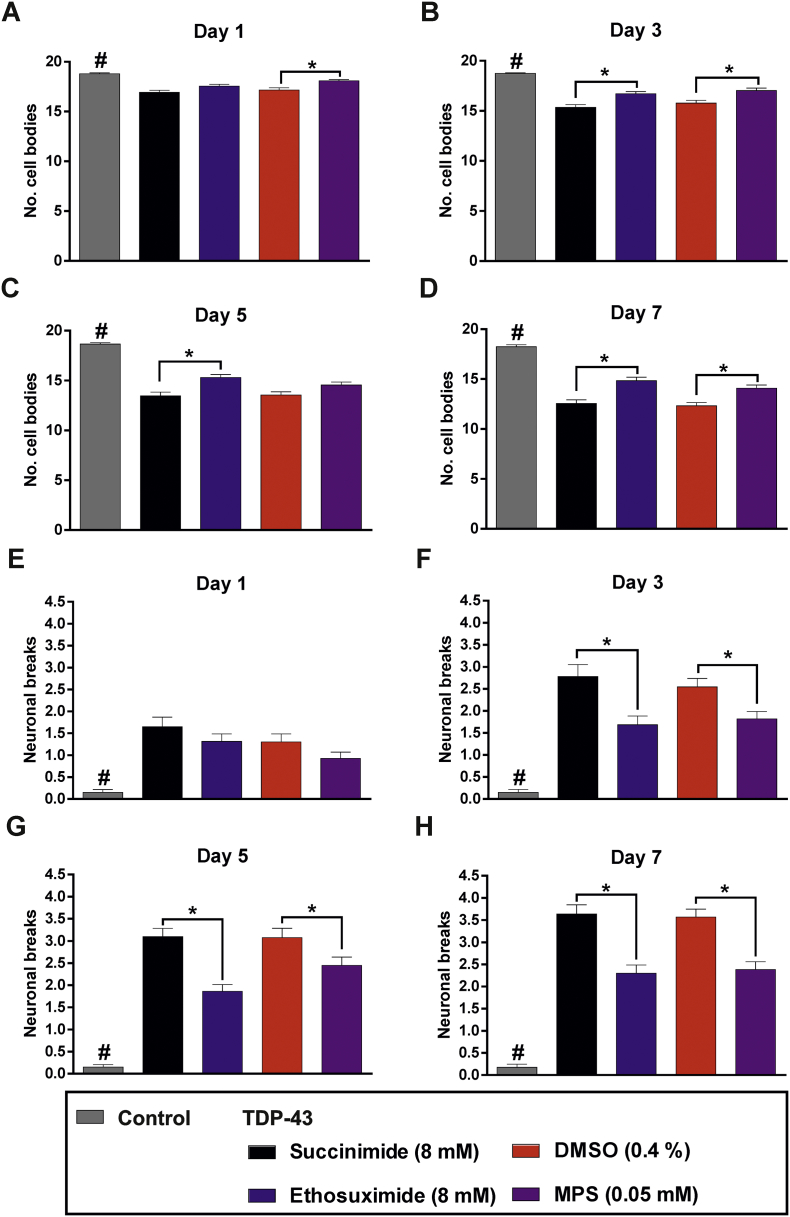
MPS ameliorates GABAergic neurodegeneration in the worm TDP-43 proteinopathy model. Age-synchronised wild type and TDP-43(A315T) worms expressing GFP under the control of the unc-25 promoter were chronically treated with the indicated compounds from the L1 larval stage onwards. (A-D) Wild type worms consistently preserved more of the 19 D-type motor neuronal cell bodies than TDP43(A315T) expressing worms at all assayed ages, verifying neurodegenerative effect of the CK426 background (#, p < .05). Both ethosuximide (B-D) and MPS (A, B and D) protected against cell body losses in TDP-43 expressing worms when compared against respective succinimide and DMSO controls (p < .05). Data for wild type (n = 30 worms per age point) and TDP-43 strains (n = 33–47 worms per age point) were pooled from two and three biological replicates respectively.(E-H) Wild type control worms had fewer neuronal breaks than TDP-43 expressing worms at all ages, (#, p < .05). Both ethosuximide and MPS reduced the number of neuronal breaks in TDP-43 expressing worms from day 3 onwards as compared to succinimide and DMSO controls (p < .05). Data for wild type (n = 40 worms per age point) and TDP-43 expressing strains (n = 43–56 worms per age point) were pooled from three and four biological replicates respectively. All statistical comparisons in A-H were made via the Kruskal-Wallis test with Dunn's multiple comparisons; #, *, p < .05.